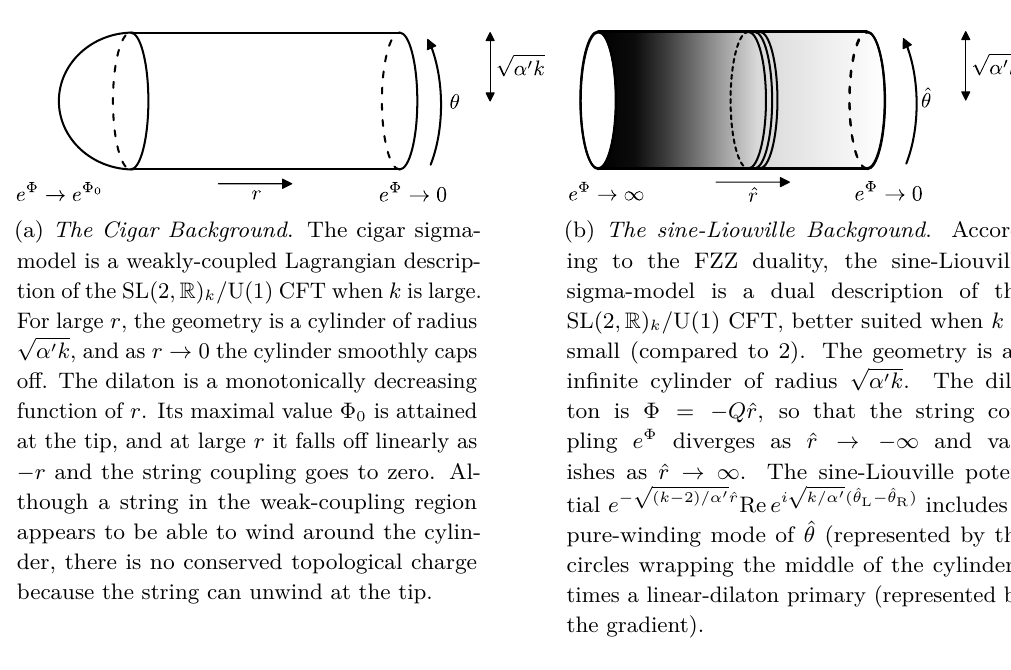
Figure 3 . The Cigar and sine-Louiville